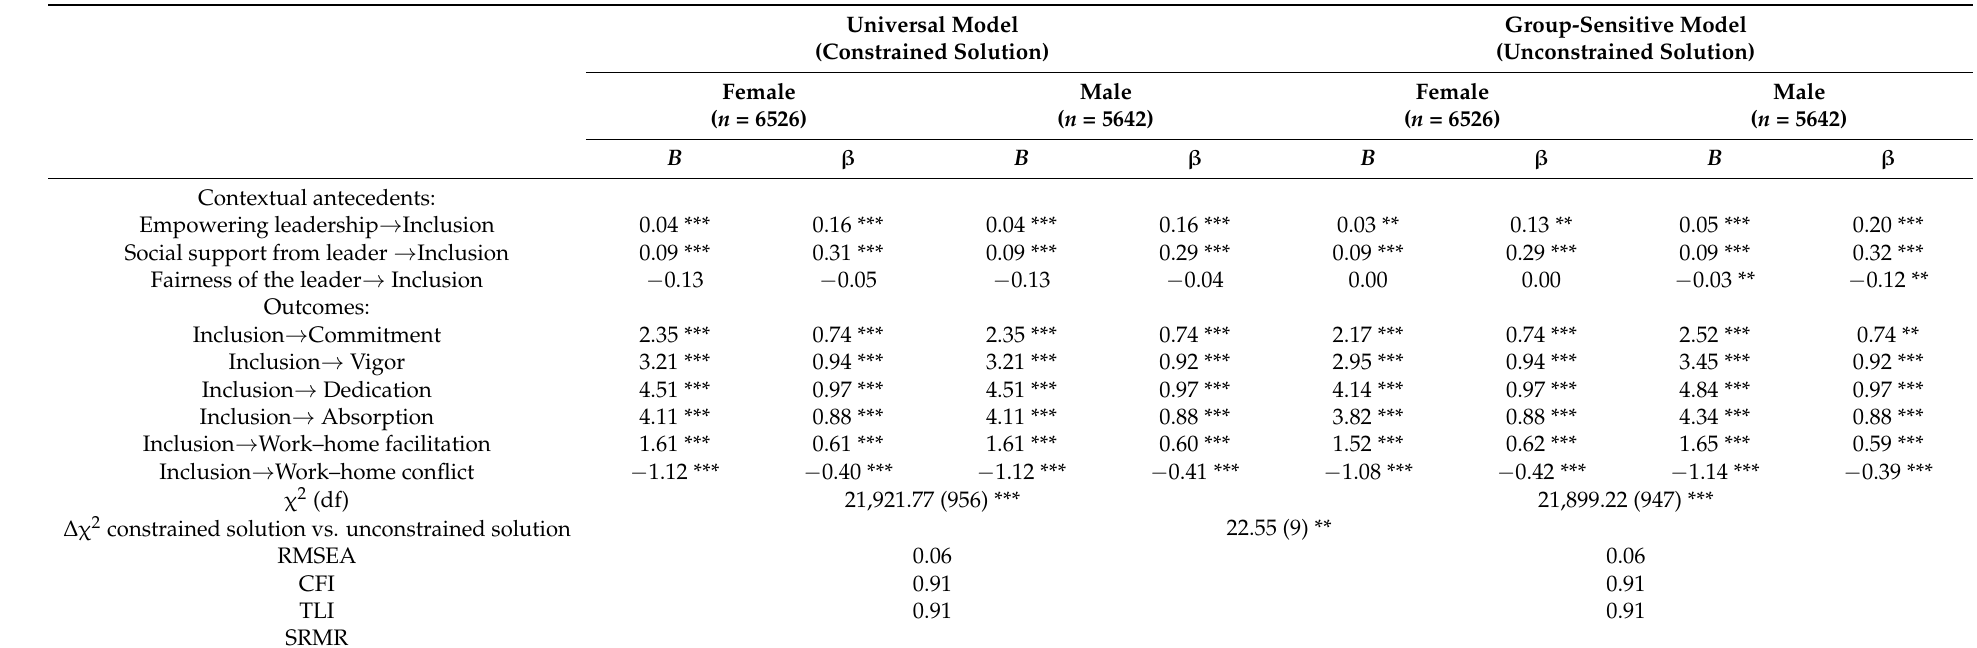
Table 4. Path coefficients of the multigroup structural equation (MG-SEM) model, by gender.